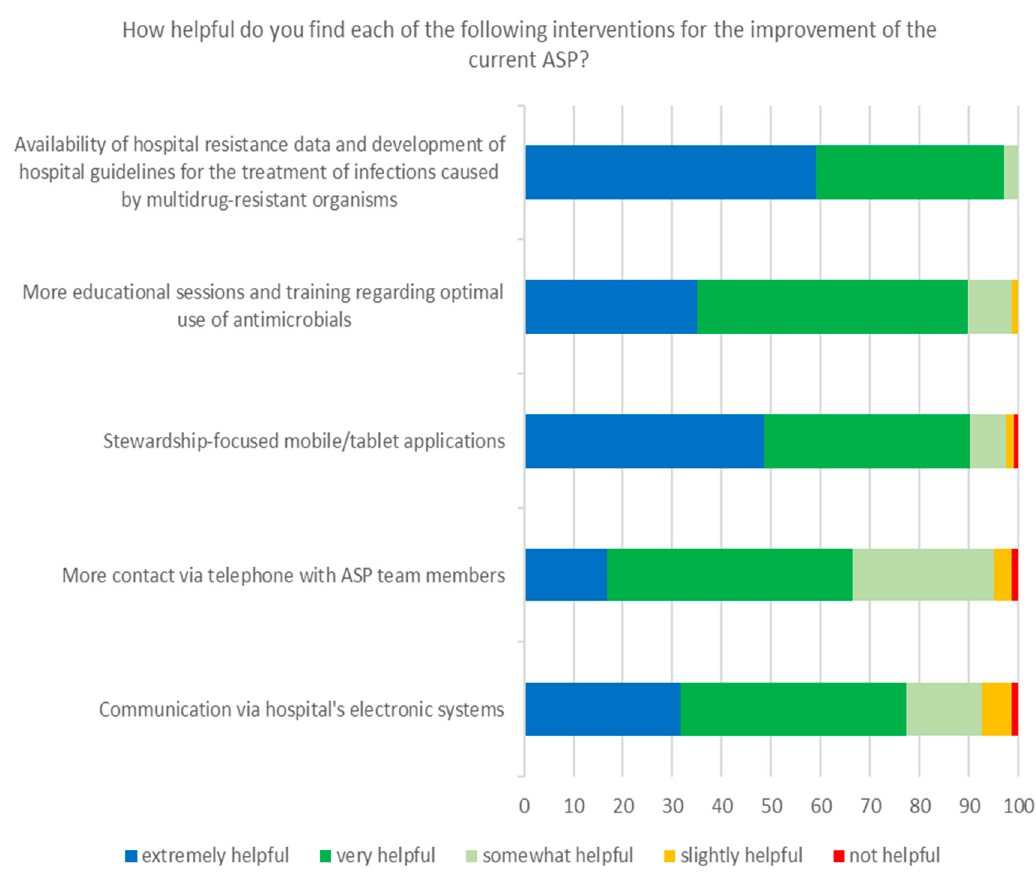
Figure 3. Respondents’ perceptions regarding potential interventions to improve our hospital’s ASP.